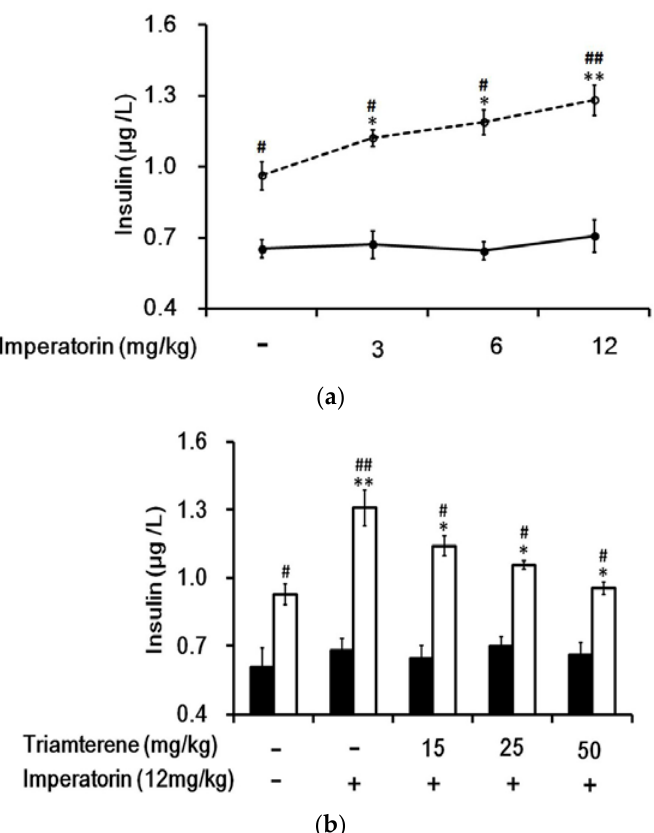
Figure 6. Effects of imperatorin on the plasma insulin levels in type 1-like diabetic rats. ( a ) The plasma insulin levels were determined 50 min after the administration of imperatorin at the indicated dose in the vehicle-treated group (solid line) or in the sitagliptin-treated (5 mg/kg/day orally for 14 days) group (broken line). ( b ) Triamterene inhibited the imperatorin-induced increase in the plasma insulin levels in diabetic rats that received vehicle (black column) or 5 mg/kg/day sitagliptin (open column) orally for 14 days. The diabetic rats were pretreated with triamterene at the indicated dose for 30 min. The values are expressed as the mean ± SEM obtained from eight samples per group. "-" is presented as 0 mol/L. "+" is presented as imperatorin treatment.* p < 0.05 and ** p < 0.01 compared with the vehicle-treated group. # p < 0.05 and ## p < 0.01 compared with the basal group without sitagliptin treatment.